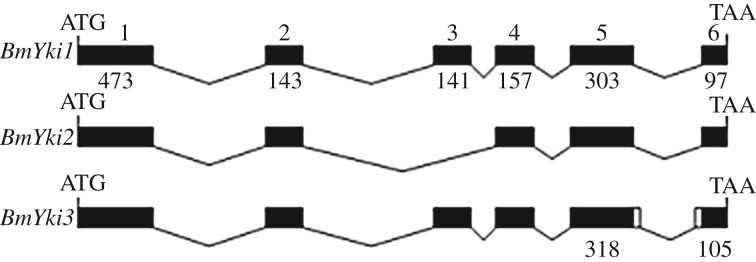
Three isoforms of BmYki are generated by alternative splicing in the silkworm. BmYki1 (KF904339) has six exons 473, 143, 141, 157, 303 and 97 nt in length. Exon 3 of BmYki1 is absent in BmYki2 (KF904340), while exon 5 of BmYki3 (KF904341) has an additional 15 nt at its 3′-end. Exon 6 of BmYki3 has an additional 6 nt at its 5′-end when compared with the corresponding exons.